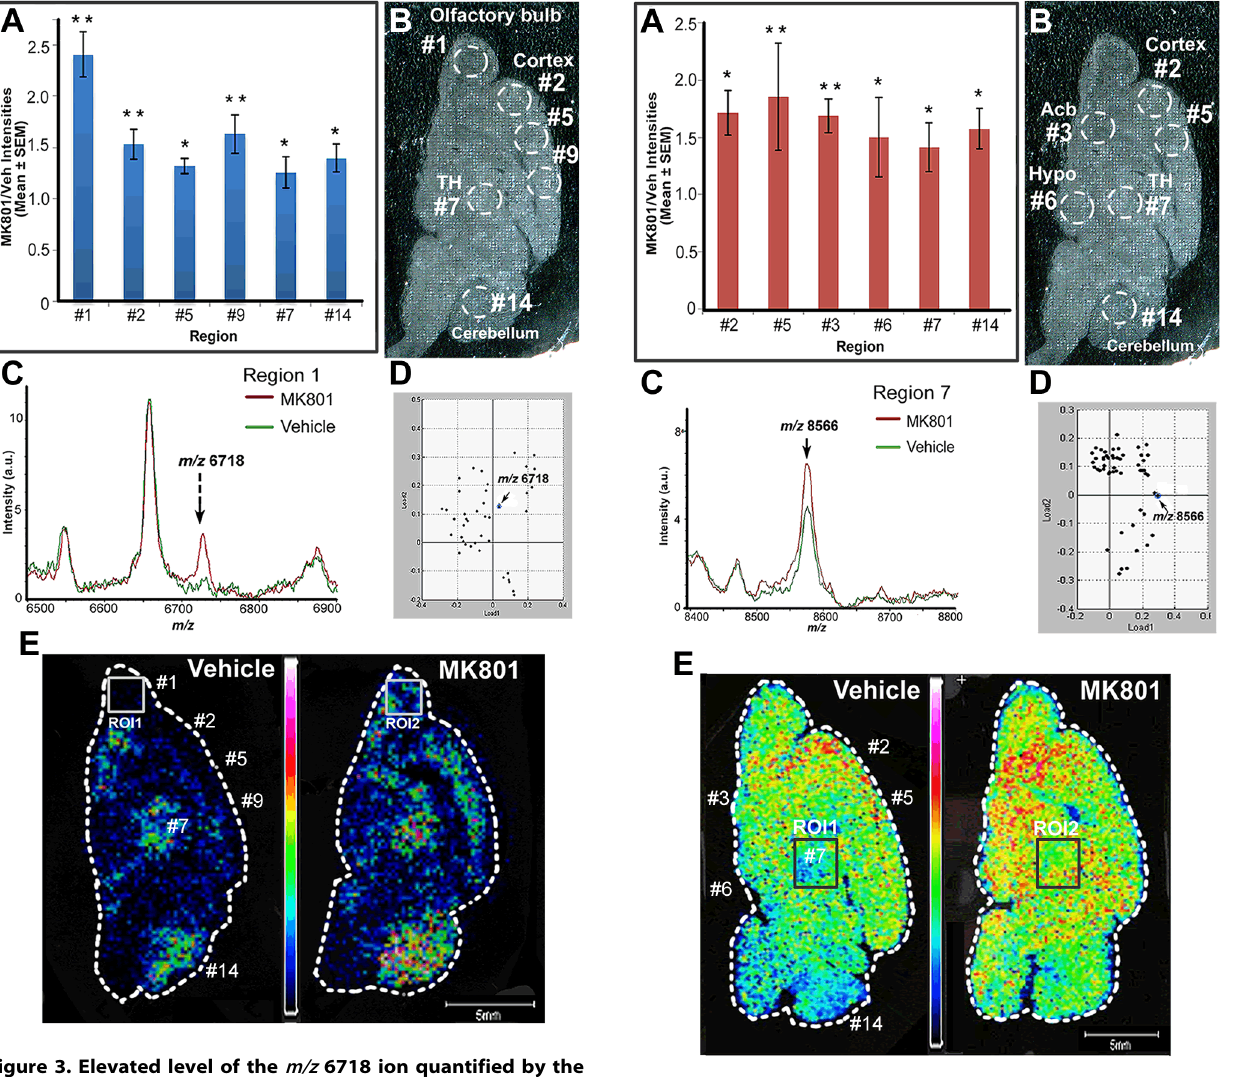
Figure 4. Elevated level of the m/z 8566 ion quantified by the strategy combining MS profiling and imaging. A) The ratios of the intensities of the ion at m/z 8566 in the profiling spectra of specific regions, regions # 2, # 5, # 3, # 6, # 7 and # 14, where the ion was concentrated. *, p , 0.05; **, p , 0.01, unpaired student’s t-test. (B) An optical image of a rat brain section washed after MSI experiments. (C) The m/z 8566 ion was up-regulated in the averaged MSI spectrum of the thalamus (TH) regions, ROI 1 and ROI2, of the rat brain section treated with vehicle and MK801 as shown in (E). (D) A loading plot of ROI 1 and ROI 2 analyzed by ClinProTools. The m/z 8566 ion was shown to contribute significantly in differentiating the two ROIs in Load 1. (E) MS images of the ions at m/z 8566 for the vehicle and the MK801- treated rat brain sections. The m/z 8566 ion was more concentrated in the frontal cortex, accumbens nucleus (Acb), thalamus (TH) and cerebellum regions in the MK801-treated section compared to the vehicle-treated